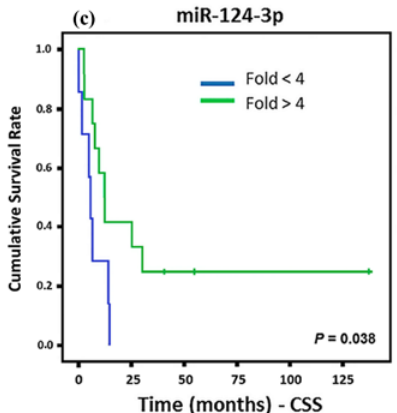
Figure 3. Kaplan Meier curves and estimates of CSS associated with miRNA expression in CS patients. ( a – c ) The expression profiles of miR-184 and miR-124-3p showed associations with CSS ( n = 19) ( p = 0.016 and p = 0.038, respectively) in both cases; while let-7b-5p exhibited a strong association with CSS ( n = 19) ( p < 0.001).